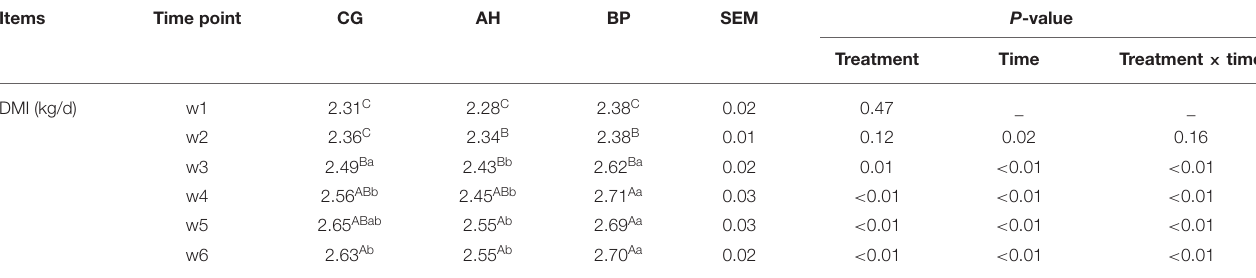
TABLE 3 | The changes in DMI of goats. Items